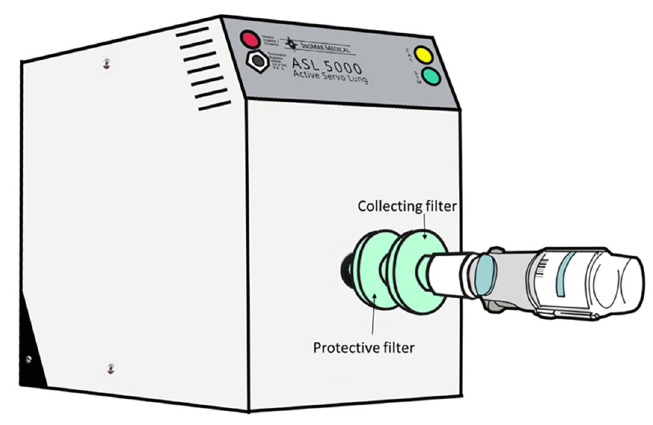
Figure 3. The experimental setup of spontaneous breathing model. A soft moisture inhaler attached to a collecting filter and then the breathing simulator.